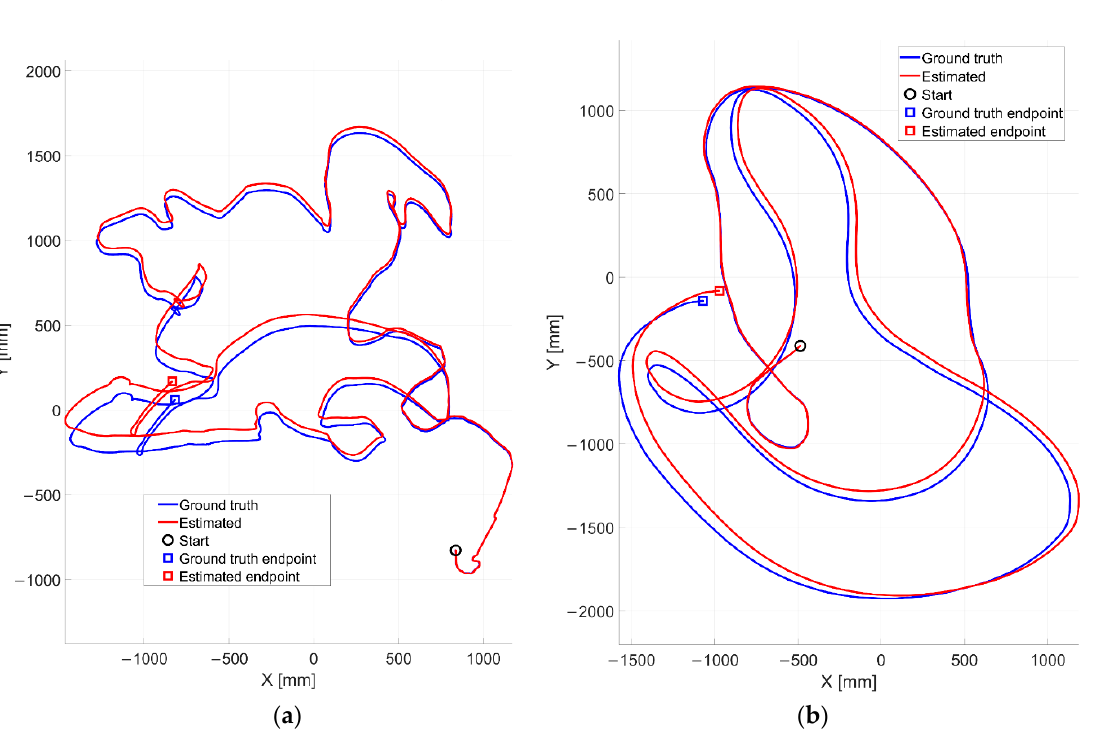
Table 1. Classification of the experiments according to the floor typology.